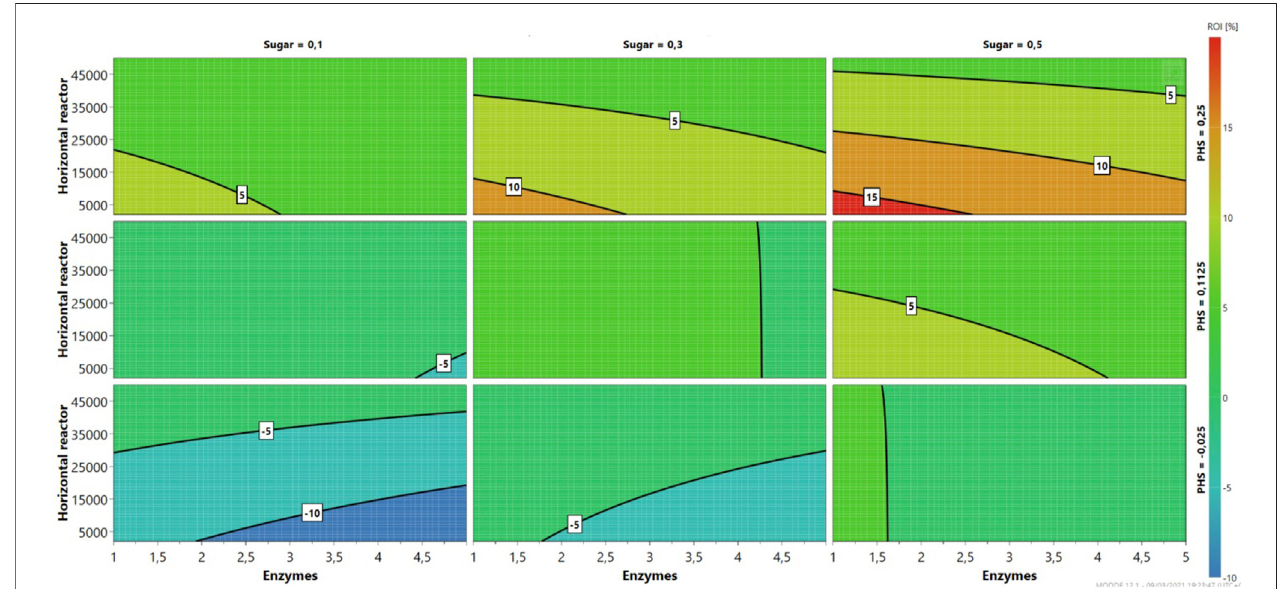
FIGURE 2 | Sensitivity analysis (4D contour plots) of the 6/48 pilot-scale con fi guration, mapping pro fi ts as a function of enzymes and sugar costs for three levels.